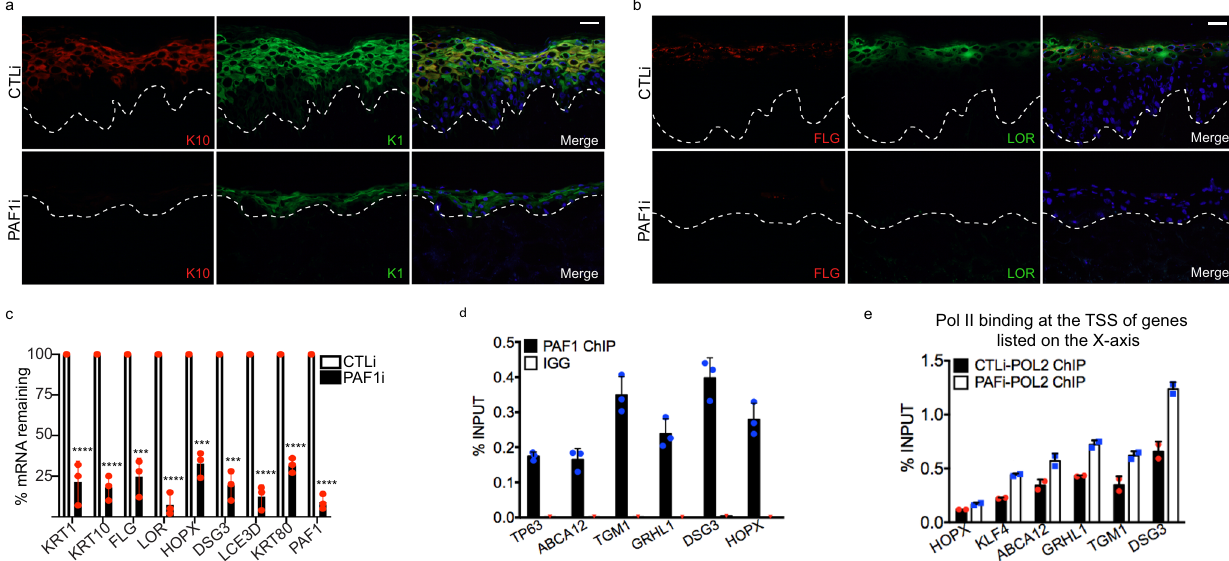
Fig. 4 PAF1 is necessary for differentiation by promoting transcription elongation. a Immuno fl uorescent staining of early differentiation markers Keratin 10 (K10: red) and Keratin 1 (K1: green) in day 6 regenerated human epidermis treated with control (CTLi) or PAF1 siRNAs (PAF1i). Merged image includes Hoechst staining of nuclei. n = 3 independent experiments. Scale bar = 50 μ m. b Immuno fl uorescent staining of late differentiation markers FLG (red) and LOR (green) in day 6 regenerated human epidermis treated with control (CTLi) or PAF1 siRNAs (PAF1i). Merged image includes Hoechst staining of nuclei. n = 3 independent experiments, scale bar = 50 μ m. c RT-qPCR quantifying the relative mRNA expression levels of epidermal differentiation genes in CTL and PAF1 knockdown regenerated human epidermis (day 6). N = 3 independent experiments, two-sided t -test. *** = 0.003 for FLG, *** = 0.0001 for HOPX, *** = 0.0001 for DSG3. **** p < 0.0001. d ChIP-QPCR of differentiation genes in differentiated primary human keratinocytes with PAF1 pulldown. IGG pulldowns were used as a negative control. All primers were targeted toward the transcription start site (TSS) of each differentiation gene. Results are shown as a percent of input. N = 3 independent experiments. e ChIP-QPCR of RNA Pol II pulldown in both CTLi and PAF1i differentiated cells. Each pulldown was normalized to its respective input and enrichment shown as a percent of input. All primers were targeted toward the TSS of each differentiation gene. N = 2 independent experiments. Mean values are shown with error bars =